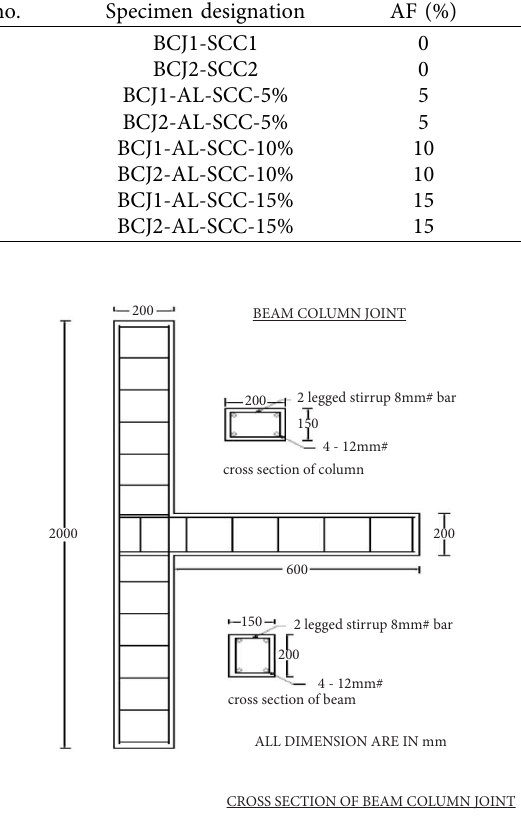
Figure 1: Typical beam column joint with reinforcement